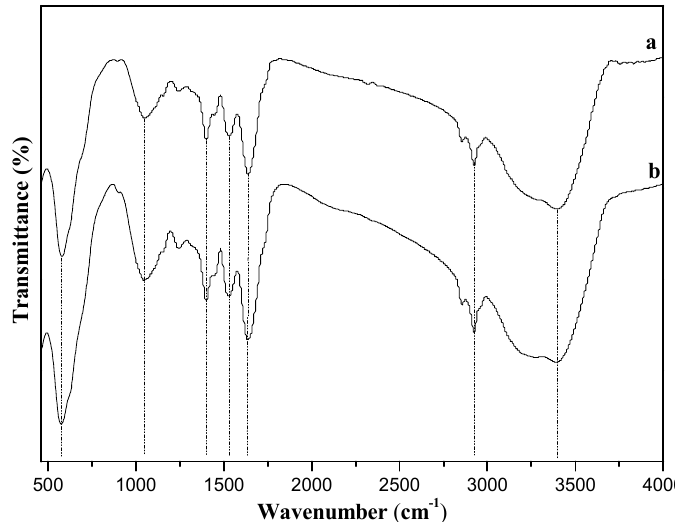
Figure 1. FT − IR spectra of 10%-Fe 3 O 4 @ SC adsorbent. a fresh, b after adsorption. The XRD spectra of the samples (including fresh and after adsorption) are shown in Figure 2. The characteristic diffraction peaks at 2 θ = 30.2°, 35.5°, 43.2°, 53.5°, 57.2° and